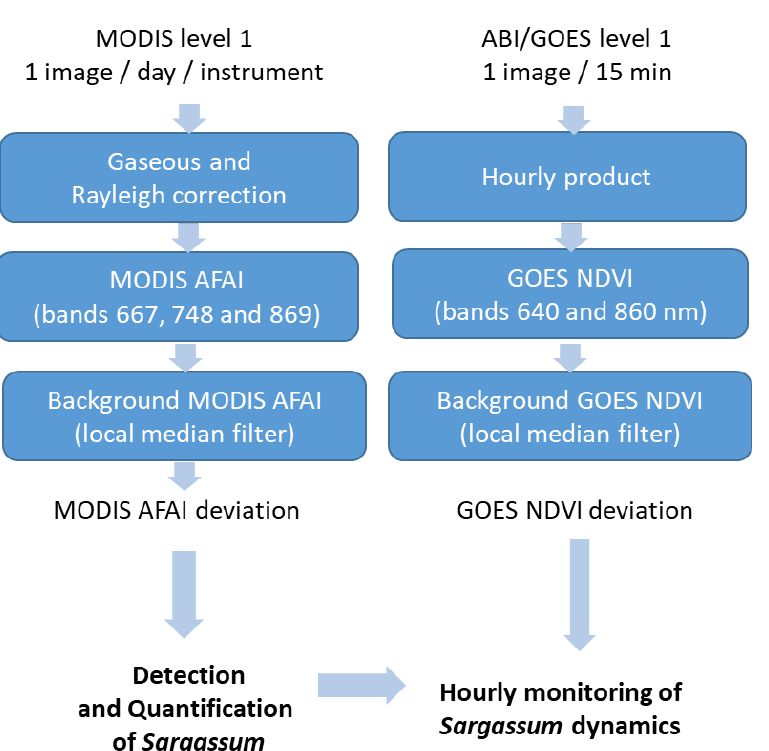
Figure 3. Flowchart of the overall methodology used to exploit the synergy between MODIS and GOES data for the characterization of Sargassum occurrence and dynamics.